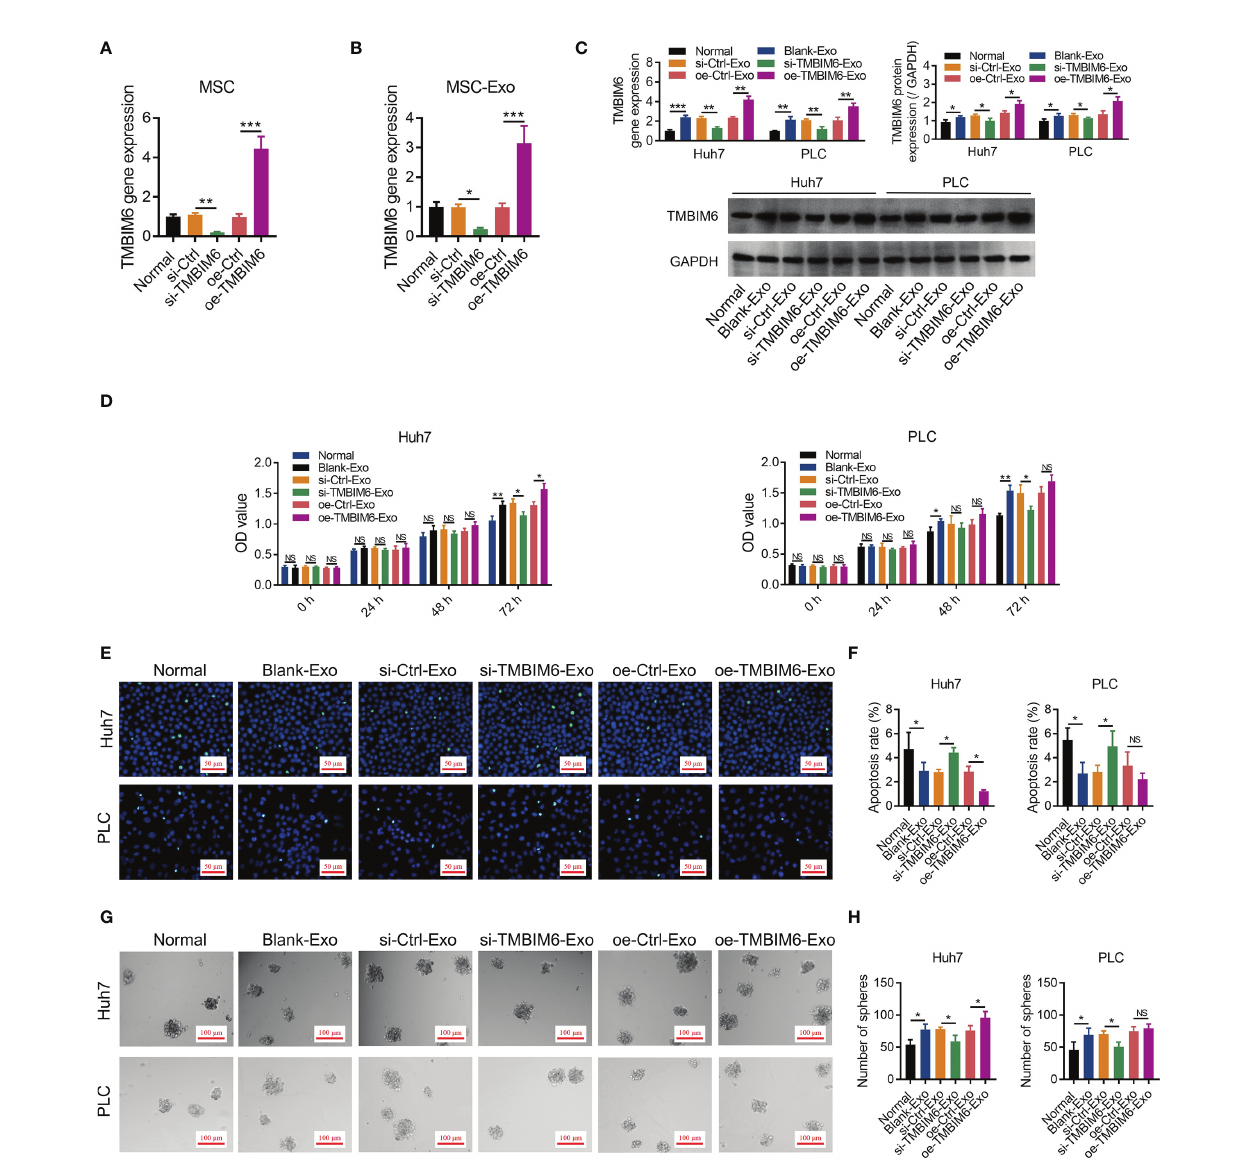
FIGURE 6 | Effect of exosomes from TMBIM6-modi fi ed HCC-MSCs on viability, apoptosis, and sphere formation ability of HCC cells. Expression of TMBIM6 in HCC- MSCs (A) and their derived exosomes (B) after transfection. Expression of TMBIM6 in HCC cells after being co-cultured with exosomes from TMBIM6-modi fi ed HCC- MSCs (C) . Comparison of viability (D) , apoptosis (E , F) , and sphere formation ability (G, H) among groups in Huh7 and PLC cells. HCC-MSCs were cultured normally or transfected with control siRNA, TMBIM6 siRNA, control overexpression plasmids, or TMBIM6 overexpression plasmids; then HCC cells were cultured normally or co- cultured with exosomes from TMBIM6-modi fi ed HCC-MSCs. Green cells indicted apoptotic cells in (E) NS, not signi fi cant; * p < 0.05; ** p < 0.01; *** p < 0.001. HCC, hepatocellular carcinoma; MSCs, mesenchymal stem